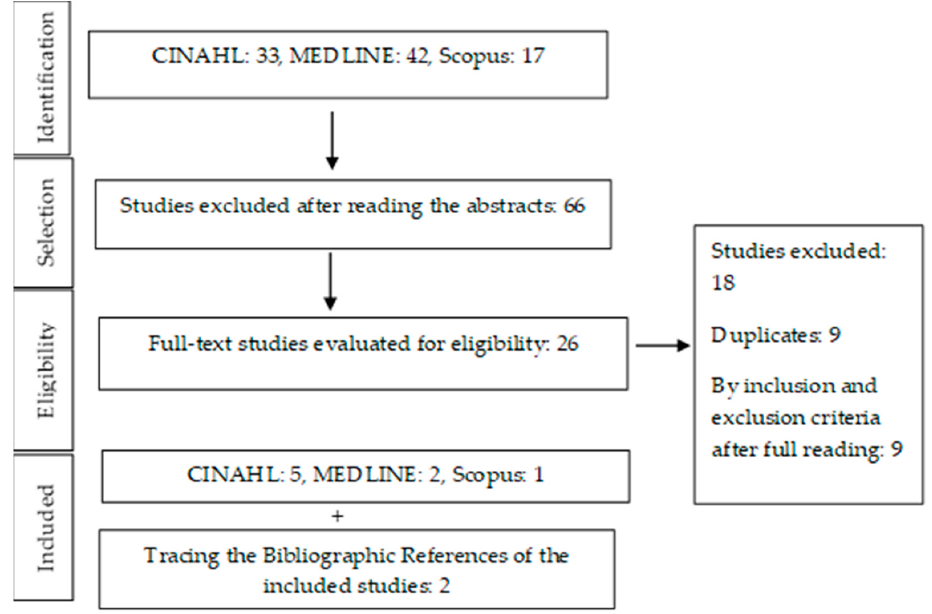
Figure 1. PRISMA flow diagram for selecting articles for review.